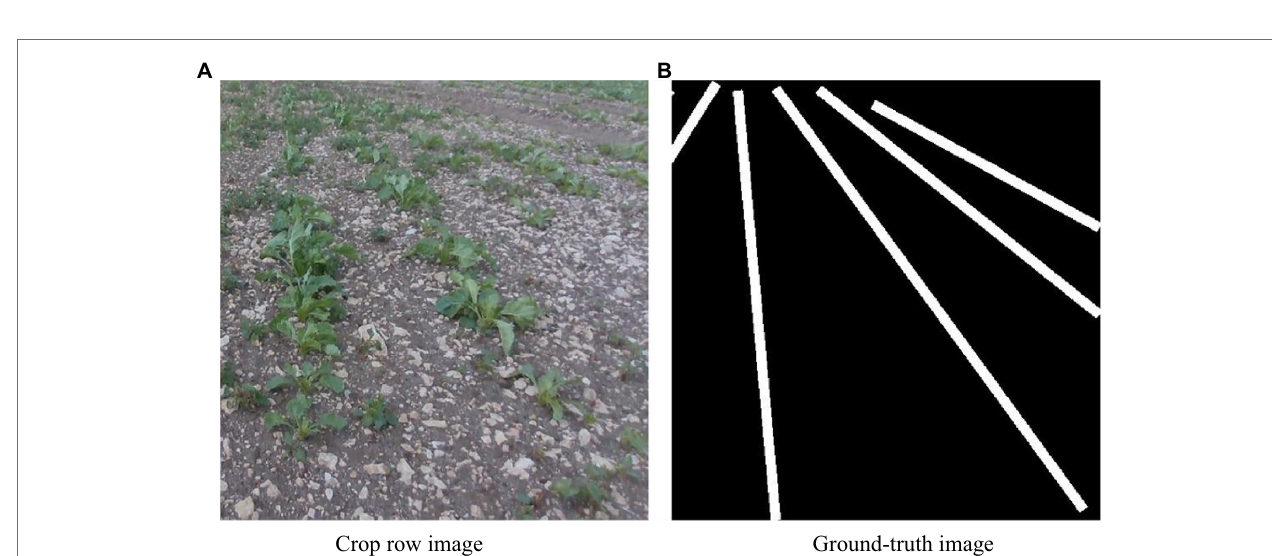
FIGURE 5 | Crop row image in a complex environment. (A) An example of a crop row image in a strong light environment. (B) Example crop row image with large areas of shadow. (C) Example crop row image with lots of weeds. (D) Example crop row image at seedling